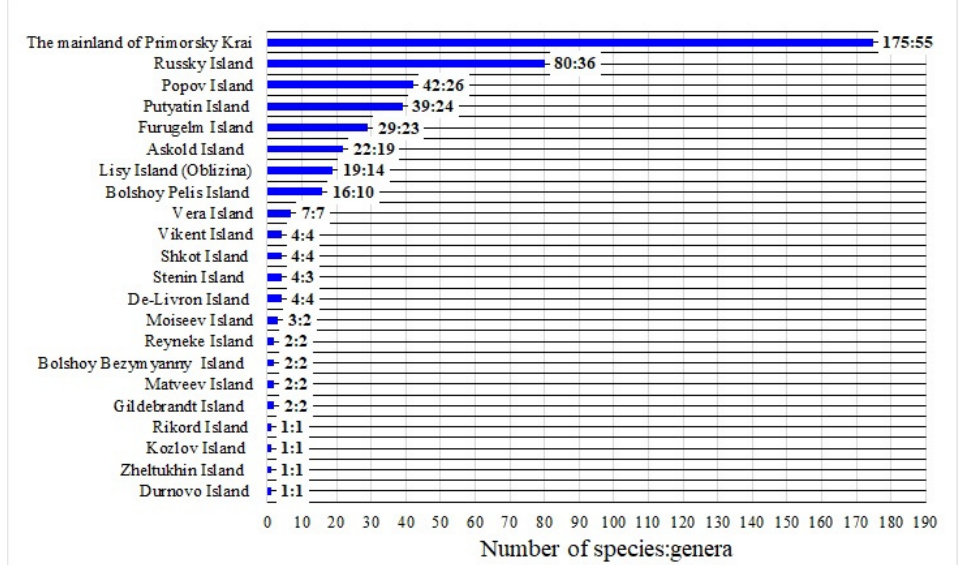
Figure 2. Distribution of Scarabaeoidea on the islands of the Peter the Great Gulf. The total fauna of 21 islands is represented by Scarabaeidae Latreille, 1802–77 species (88.5%), other families are represented with a single species: Trogidae Macleay, 1819 with five species (5.7%), Lucanidae Latreille, 1804 with three species (3.5%), Geotrupidae Latreille, 1802 with two species (2.3%). In Scarabaeidae, the Scarabaeinae dominate with 15 species (19.5%), Aphodiinae Leach, 1815 with 14 species (18.2%), and Rhizotroginae with 13 species (16.9%). It should be noted that data on Scarabaeinae from 20 islands of Peter the Great Gulf are reported for the first time. The most diverse fauna has been found on Russky Island: 80 species (92% of the total fauna of the 21 islands and 45.7% of the entire fauna of Primorsky Krai of Russia), Popov Island—42 species (48.3%), and Putyatin Island—39 species (44.8%). Kozlov, Ricord, Zhel- tukhin, and Durnovo islands have been found to host only one species each (1.1%).